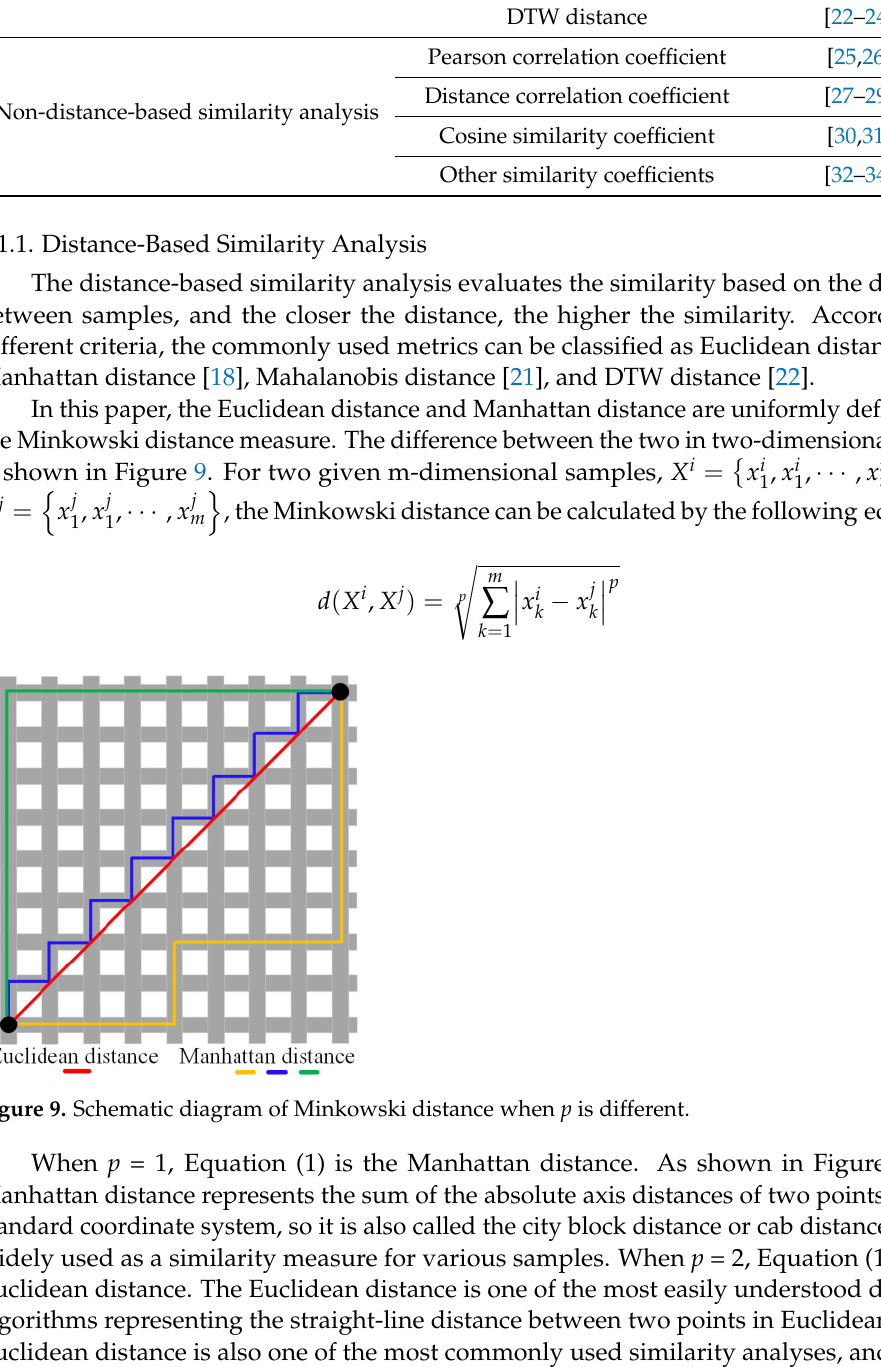
Dynamic time warping (DTW), known as the ʺ time ‐ warped ʺ distance measure, is one of the most popular time series similarity metrics and is calculated as shown in Figure 10. For distance measurement of two series, Minkowski distance requires strict alignment, whereas DTW relaxes this alignment restriction and can capture the trend similarity be ‐ tween different series very well in time series similarity analysis. Ref. [23] used weighted DTW to measure the similarity of meteorological factors between the days to be predicted and the historical days. Ref. [24] provides a standardized approach for PV system design and analysis through the DTW similarity analysis method. Moreover, it has been proved experimentally that the DTW algorithm is a simple and effective time series similarity analysis. Therefore, in virtual collection technology, DTW can analyze the time series sim ‐ ilarity of different DPVS.